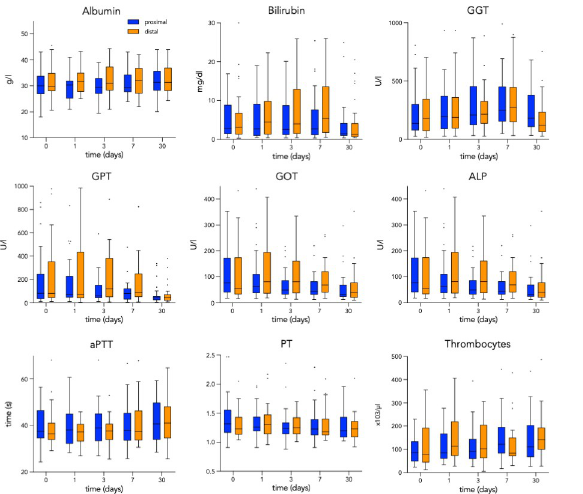
Fig 3. Boxplots showing the development of median laboratory values over time stratified regarding the site of embolization. GGT, gamma-glutamyl transferase, GPT, glutamic-pyruvic transaminase; GOT, glutamic-oxaloacetic transaminase; ALP, Alkaline Phosphatase; PT, Prothrombin Time using International Normalized Ratio (INR).